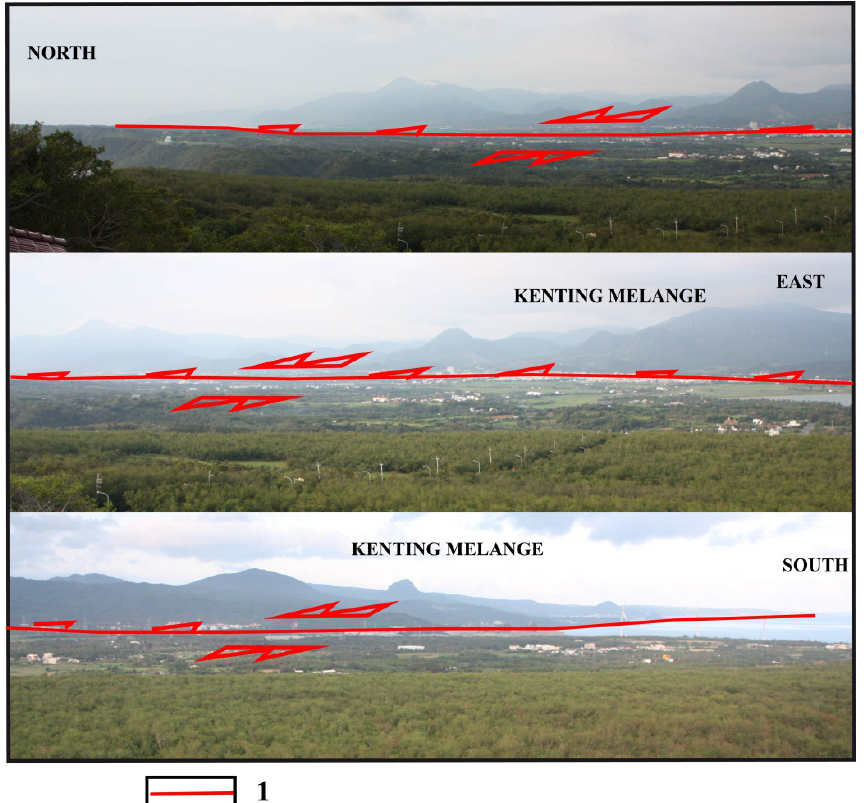
Figure 5. Panorama of the Hengchun Fault observed from the western Hengchun Hill to the east. Red lines (1) correspond to the left-lateral compressive Hengchun Fault. Note the isolated summits within the Kenting Mélange that are composed of highly deformed shales with various huge blocks (possibly olistoliths) interpreted herein as a tectonic breccia. The location and the direction of the photos where it were taken are indicated in Fig.